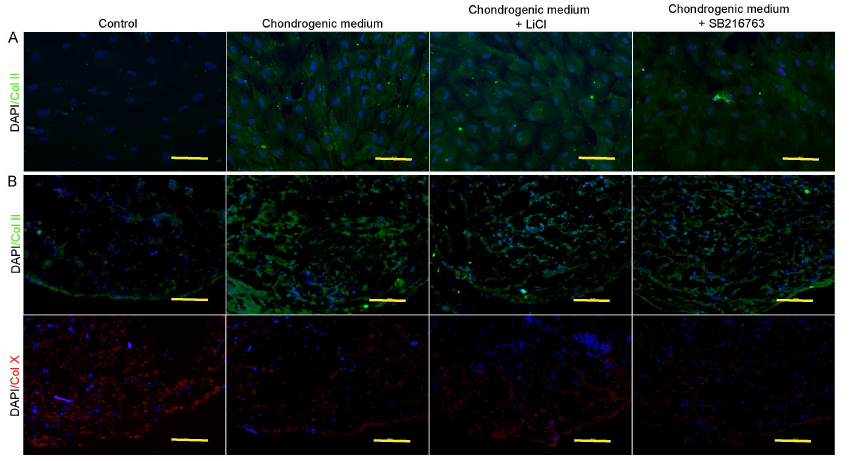
Fig 5. Immunofluorescent staining of cartilage specific type collagen. (A) immunofluorescent staining for collagentype II in monolayerexpanded cultured on 3 weeks after differentiation. Scale bar = 20 μ m. (B) Collagentype II and X expressions in pellet experiment on 4 weeks after differentiation. Scale bar = 20 μ m.